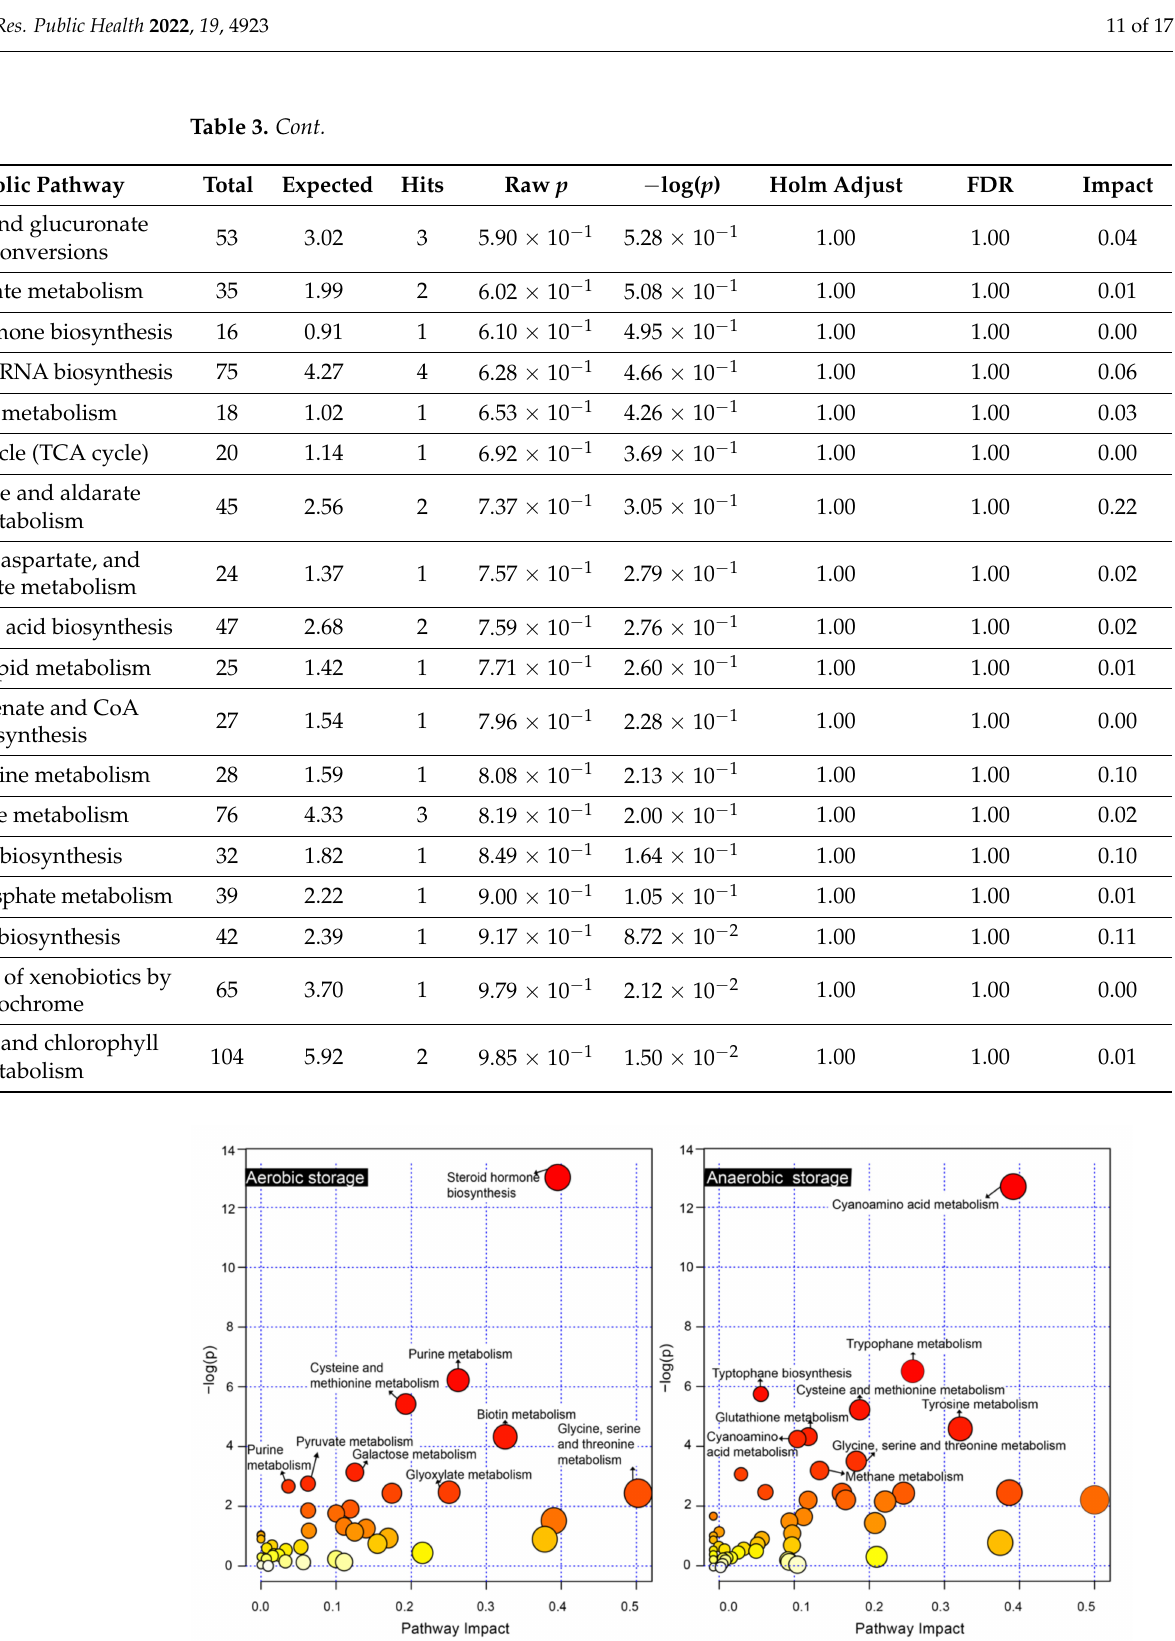
Figure 3. The metabolic pathways comparison of 20 ◦ C anaerobic and aerobic storage modes for 20 days. (Each circle represents a metabolic pathway; the horizontal coordinate represents the impact value of that pathway, and the vertical coordinate represents the result of the enrichment analysis. The color of the circles changes from white to dark red as the − log( p ) value increases, and the size of the circles is shown visually as the impact value increases from small to large, Impact >